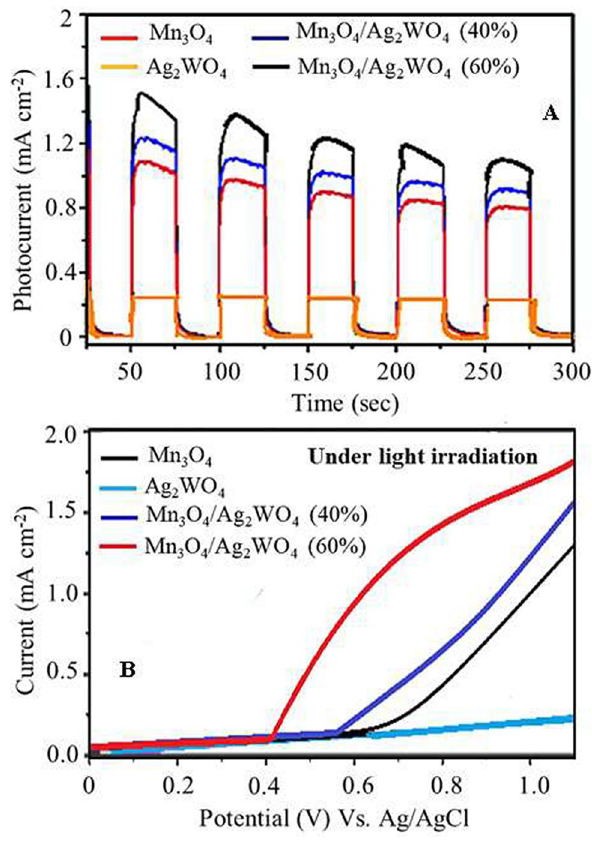
Figure 13. ( A ) Transient photocurrent responses and ( B ) linear sweep photovoltammetry (LSV) results of Ag